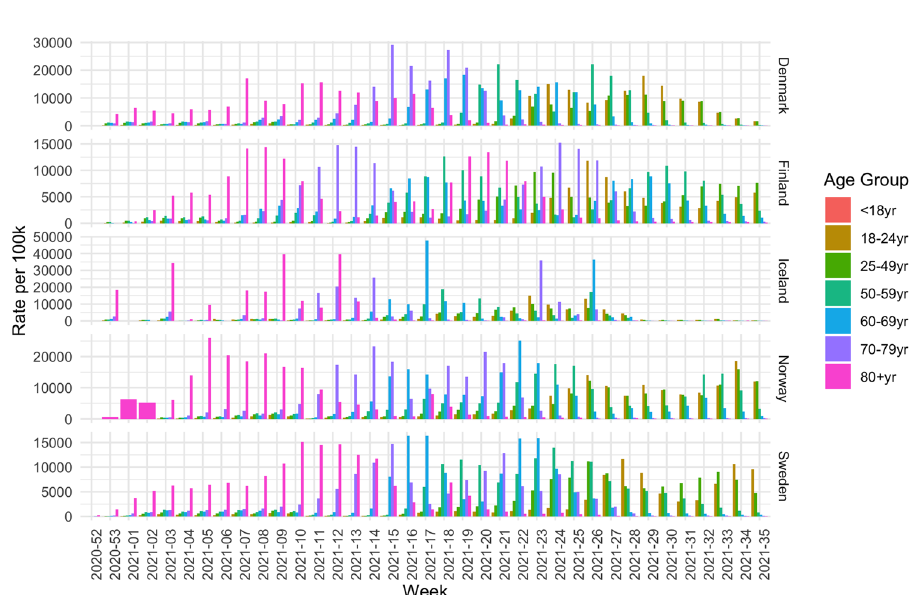
Figure 3. Number of vaccine doses per 100 thousand per age group given each